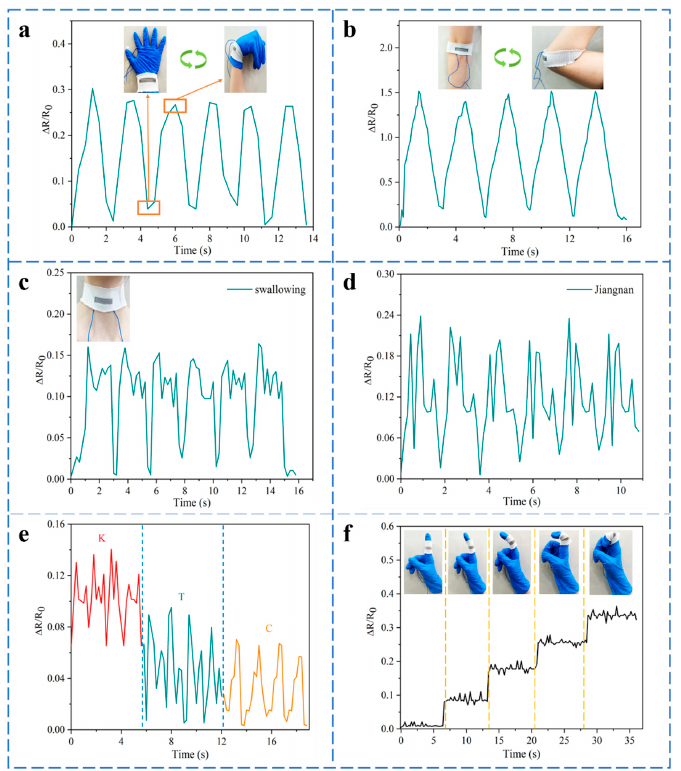
Figure 8. Application of the knitted strain sensors under the size prediction model in detecting different human movements, ( a ) wrist bending, ( b ) elbow bending, ( c ) swallowing of food, ( d ) speaking the word ‘Jiangnan’, ( e ) pronouncing words ‘K’, ‘T’, and ‘C’, ( f ) responsive curve of the sensor on the finger under diverse bending degrees.